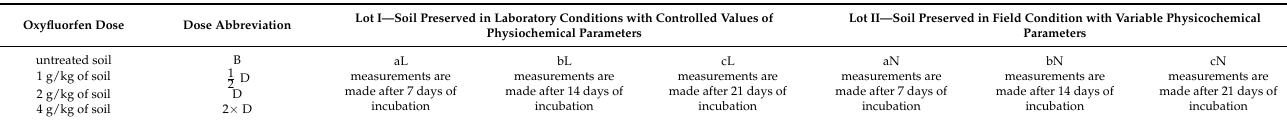
Table 1. Variants of the experimental lots of treated soil: B—untreated control soil, 1 oxyfluorfen/kg of soil), D—normal dose (2 g oxyfluorfen/kg of soil) and 2 × D—double dose (4 g oxyfluorfen/kg of